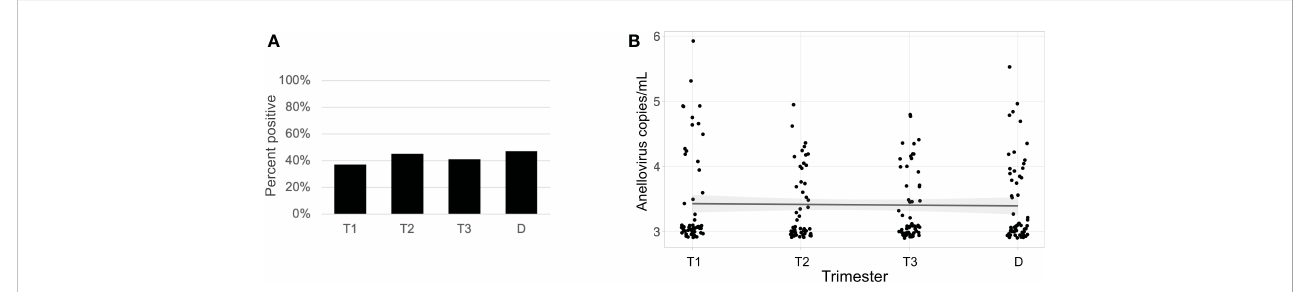
FIGURE 5 Anellovirus positivity and load are consistent throughout pregnancy in the full data set. In (A) , the percentage of maternal samples positive by PCR assay (y-axis) is shown for each time point (x-axis). In (B) , the anellovirus copy number (load) in copies per mL (y-axis) is shown for each time point (x-axis), and the fi tted line is plotted with the 95% con fi dence interval shaded. T1, Trimester 1; T2, Trimester 2; T3, Trimester 3; D, Delivery.